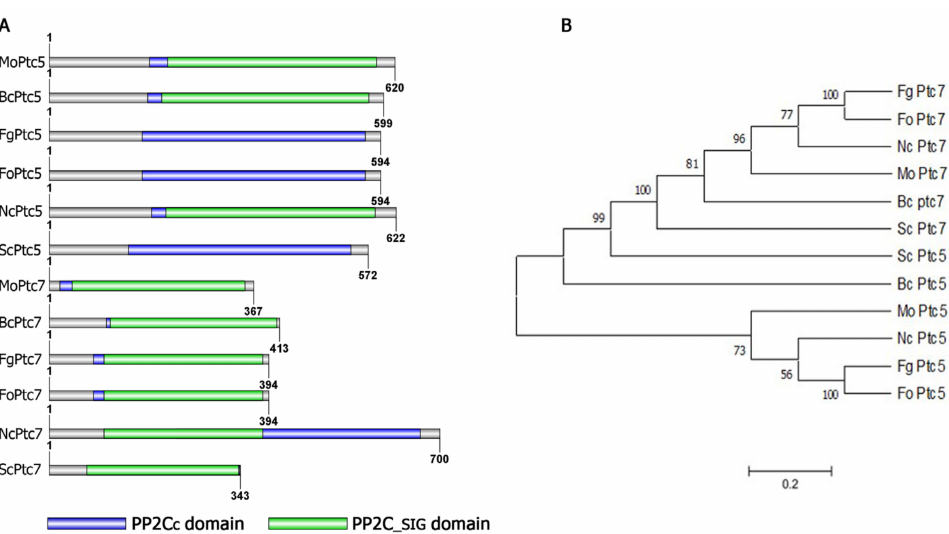
Figure 1. Domain architecture and phylogenetic analysis of Ptc5 and Ptc7 in different fungi. ( A ) Do- main architecture of Ptc5 and Ptc7 orthologs in in different organisms. ( B ) A phylogenetic tree generated using MEGA X software and a UPGMA test with 1000 Boot straps replications was con- ducted. Fg: Fusarium gamineum ; Fo: Fusarium oxyporum ; Nc: Neurospora crassa ; Mo: Magnaporthe oryzae ; Bc: Botytis cinera ; and Sc: Saccharomyces cerevisae